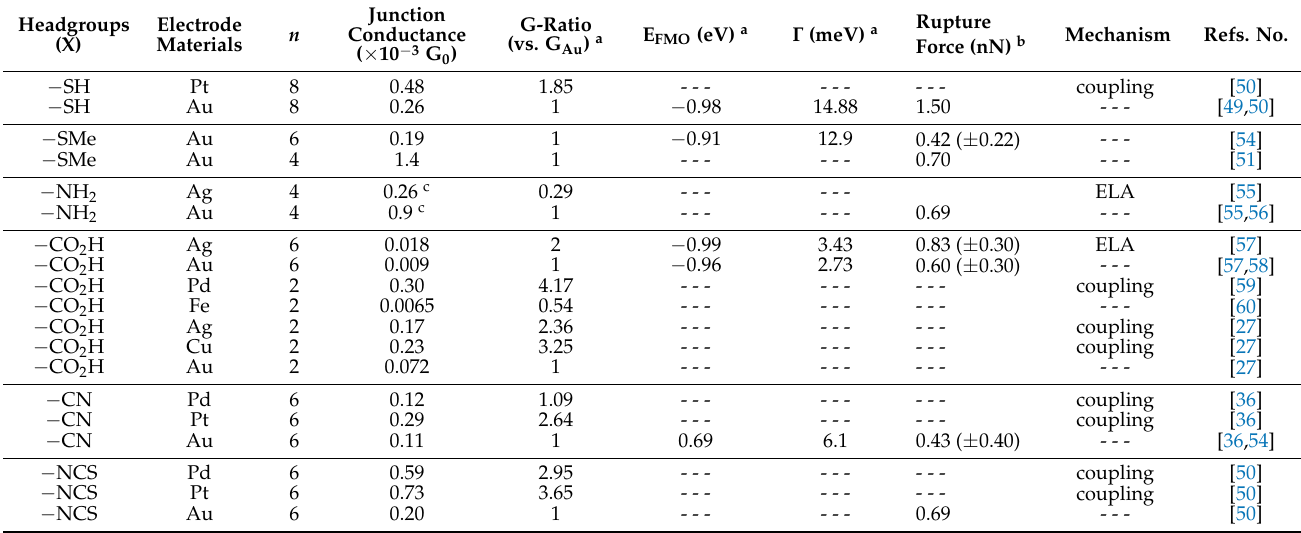
Table 1. Examples of molecule–electrode interfacial properties for single-molecule junctions of α , ω -alkanes (X-(CH 2 ) n